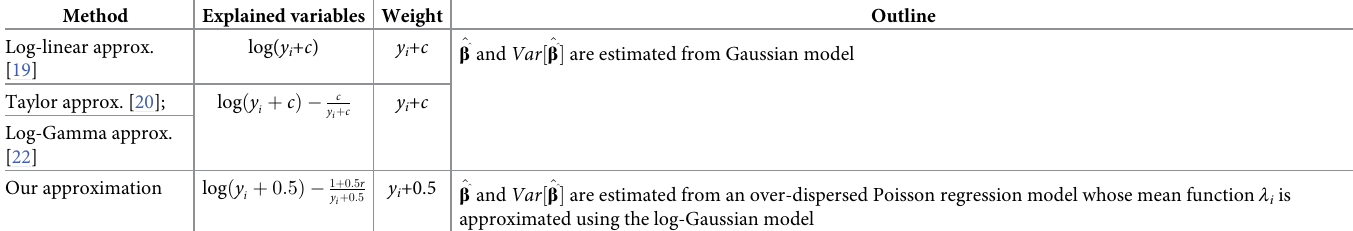
^ ^ β ^ and Var ½ β ^ � are estimated from Gaussian model